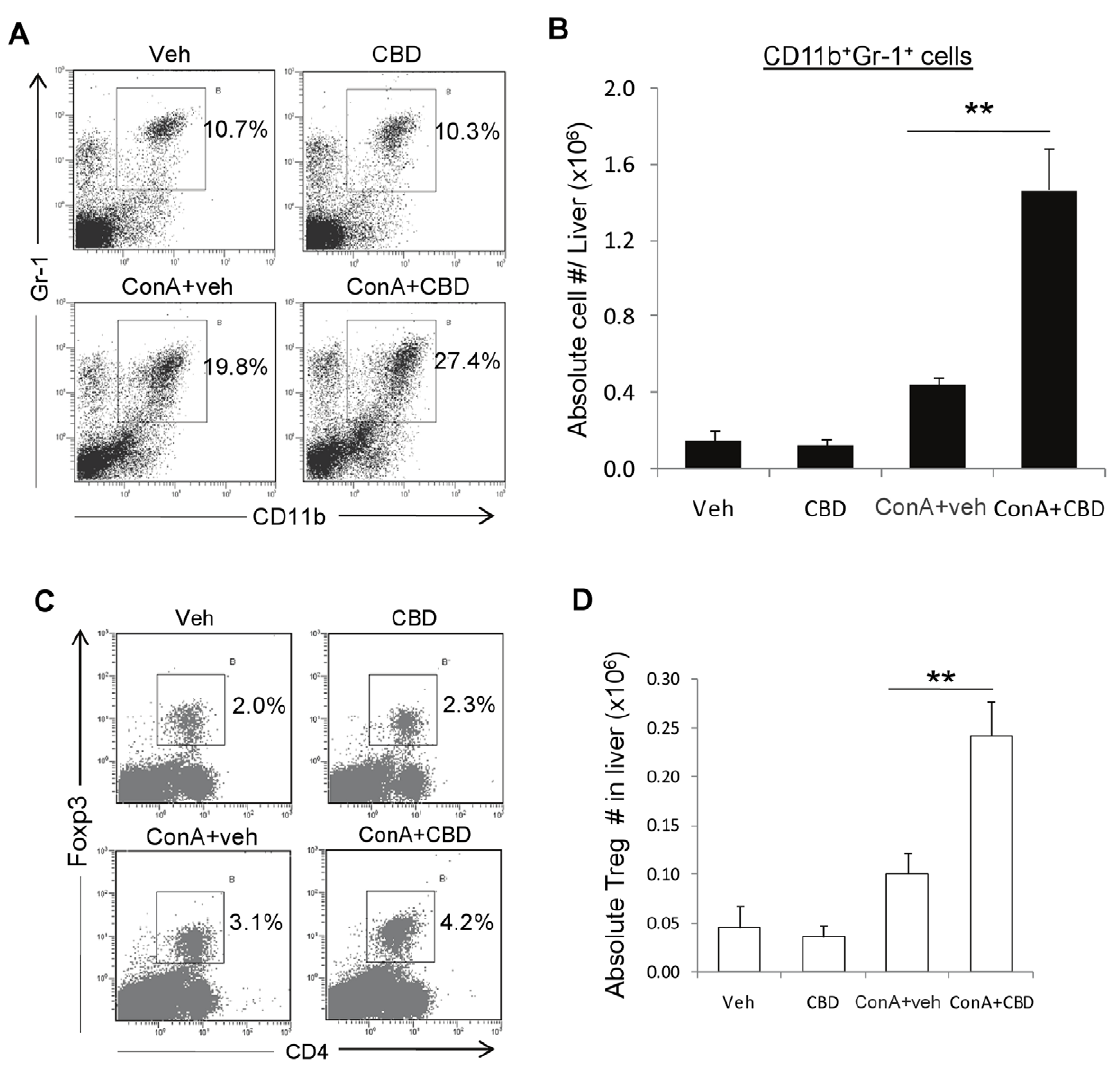
Figure 3. Phenotypic characterization of liver infiltrating cells: CBD treatment of hepatitis increases predominantly CD11b + Gr-1 + cell numbers in liver. WT mice were injected with PBS (Veh) or ConA. ConA injected mice were simultaneously administered ( i.p. ) with vehicle or CBD (25 mg/kg bd.wt.). CBD group received CBD alone at 25 mg/kg bd.wt. Liver infiltrating cells isolated after 12 h were stained for CD11b and Gr-1, and analyzed by FACS. Representative flow profiles for each sample showing frequency of CD11b + Gr-1 + cells (gated) is shown in panel A. Absolute numbers of CD11b + Gr-1 + cells were calculated from percentages and total cell numbers per liver (B). Cells were also stained and analyzed for Foxp3 + Tregs (D, E). Data represent mean 6 SEM from 4 mice per treatment. Data were analyzed by Student’s t -test (*p , 0.05, **p ,